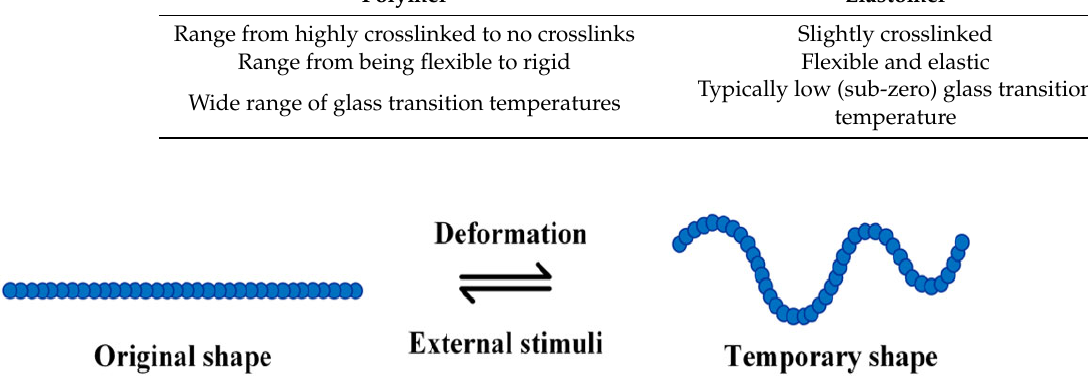
Table 1. Key differences between polymers and elastomers relevant to shape memory behaviour.